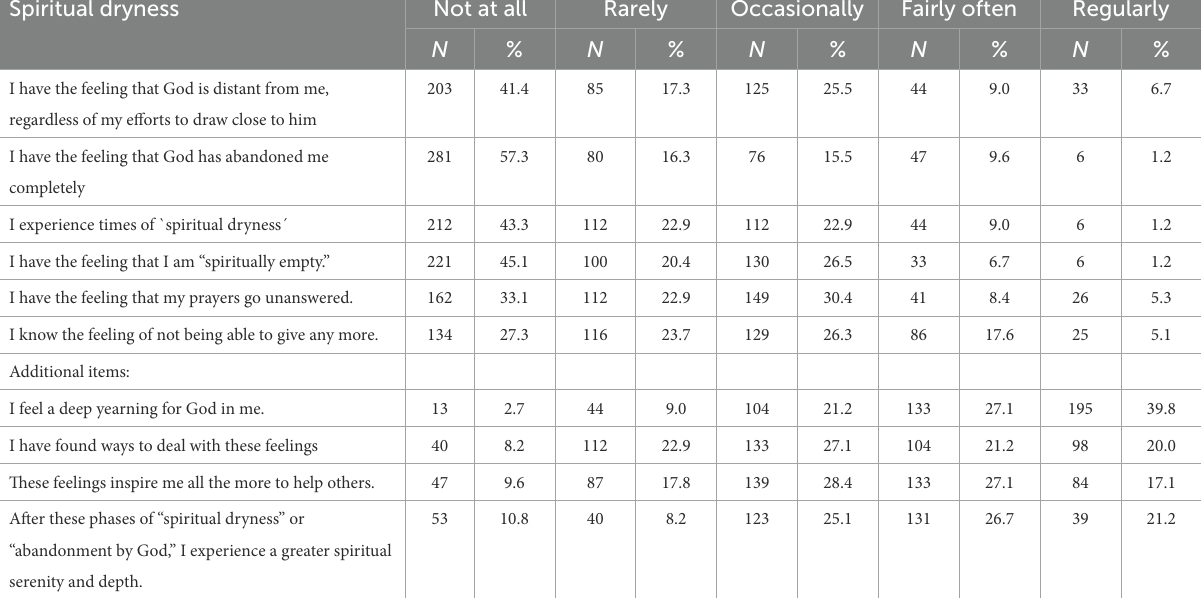
TABLE 2 Frequency of spiritual dryness perceptions.